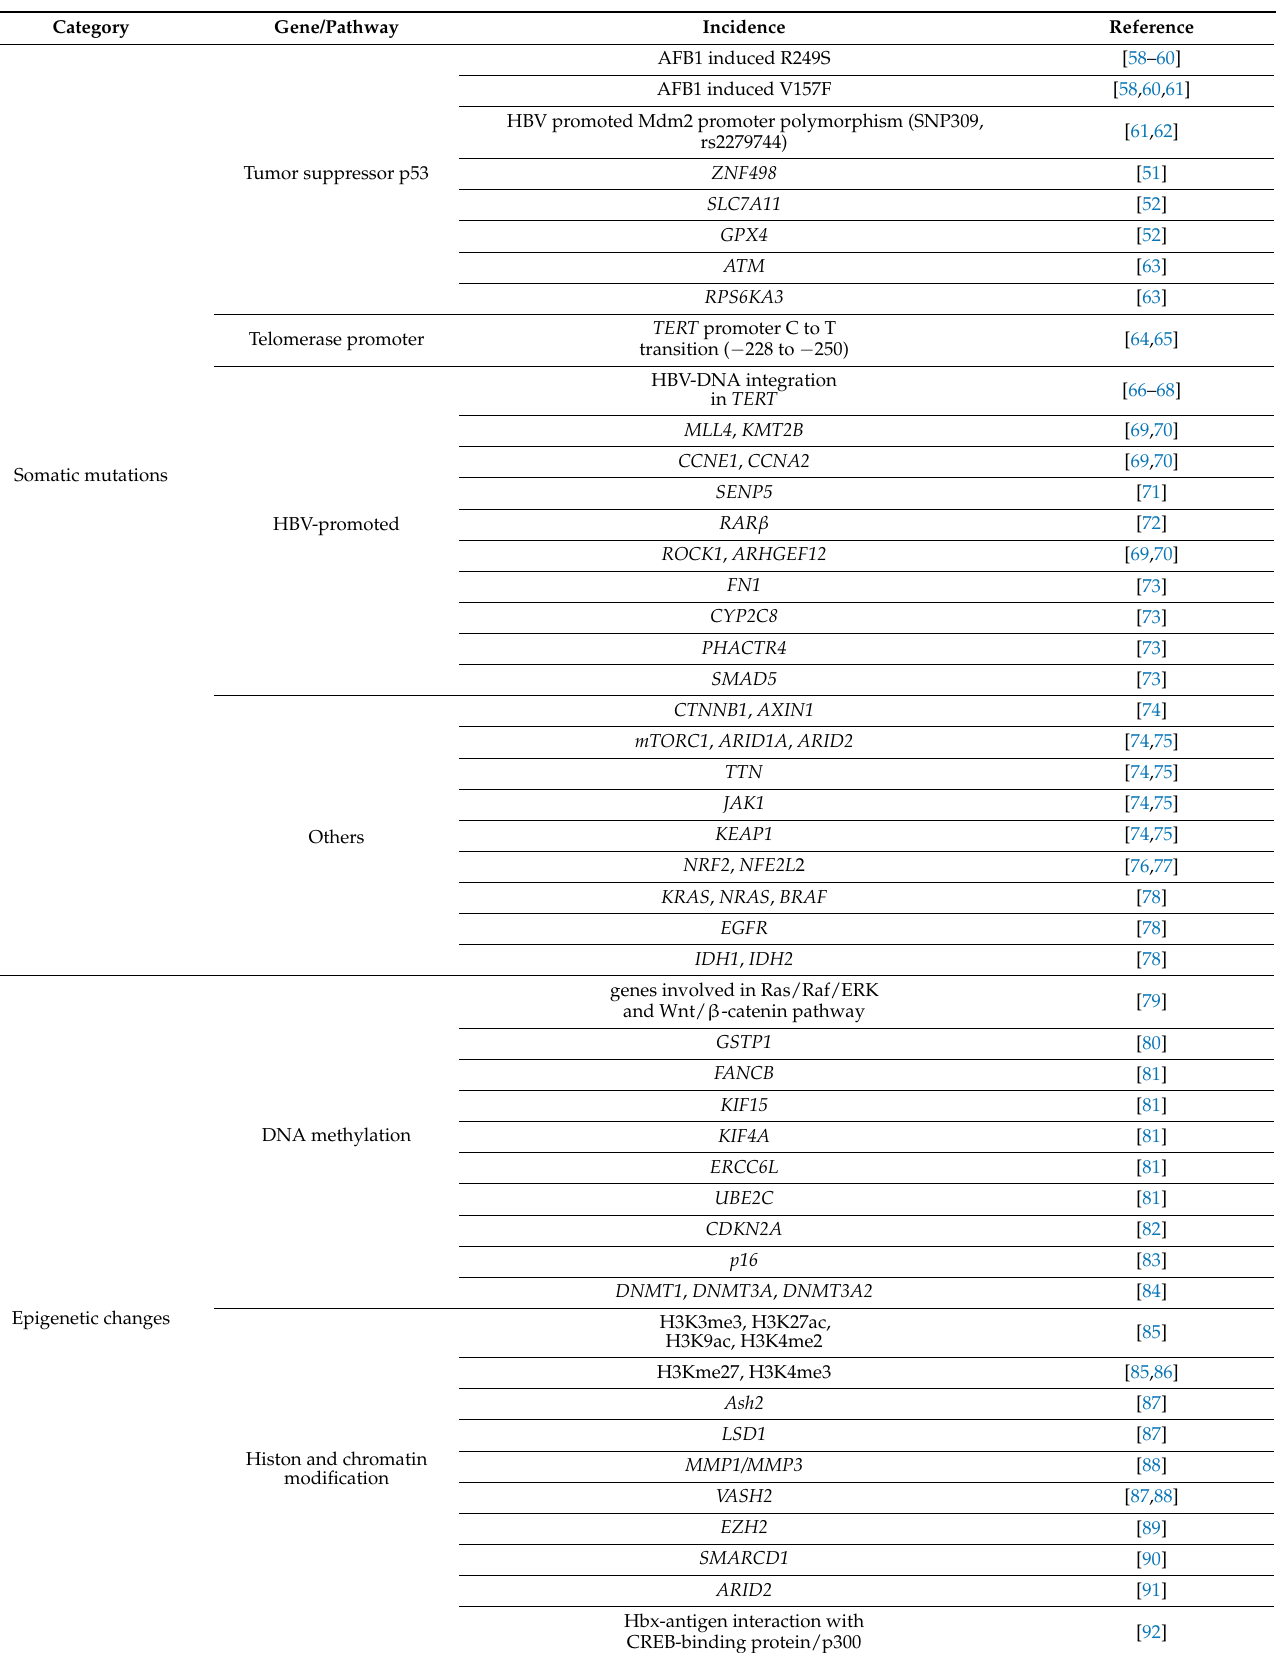
Table 1. Pathophysiological factors involved in HCC carcinogenesis (gene mutation, miRNA, lncR- NAs, epigenetic changes, alteration in signaling pathways, etc.). The right column contains the corresponding